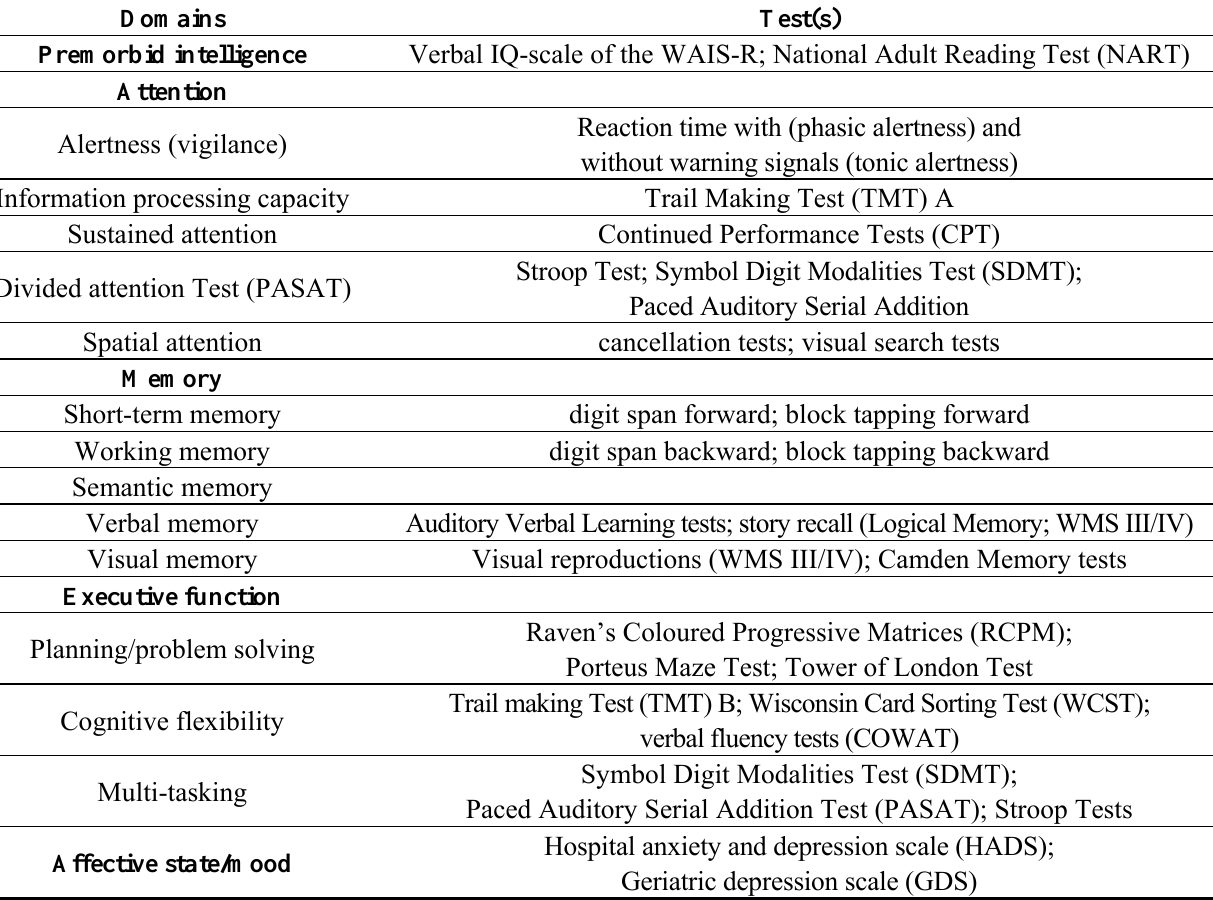
Table 2. Recommendations for a standardized assessment of cognition and affective state/mood (for a detailed and comprehensive description of assessment measures, see